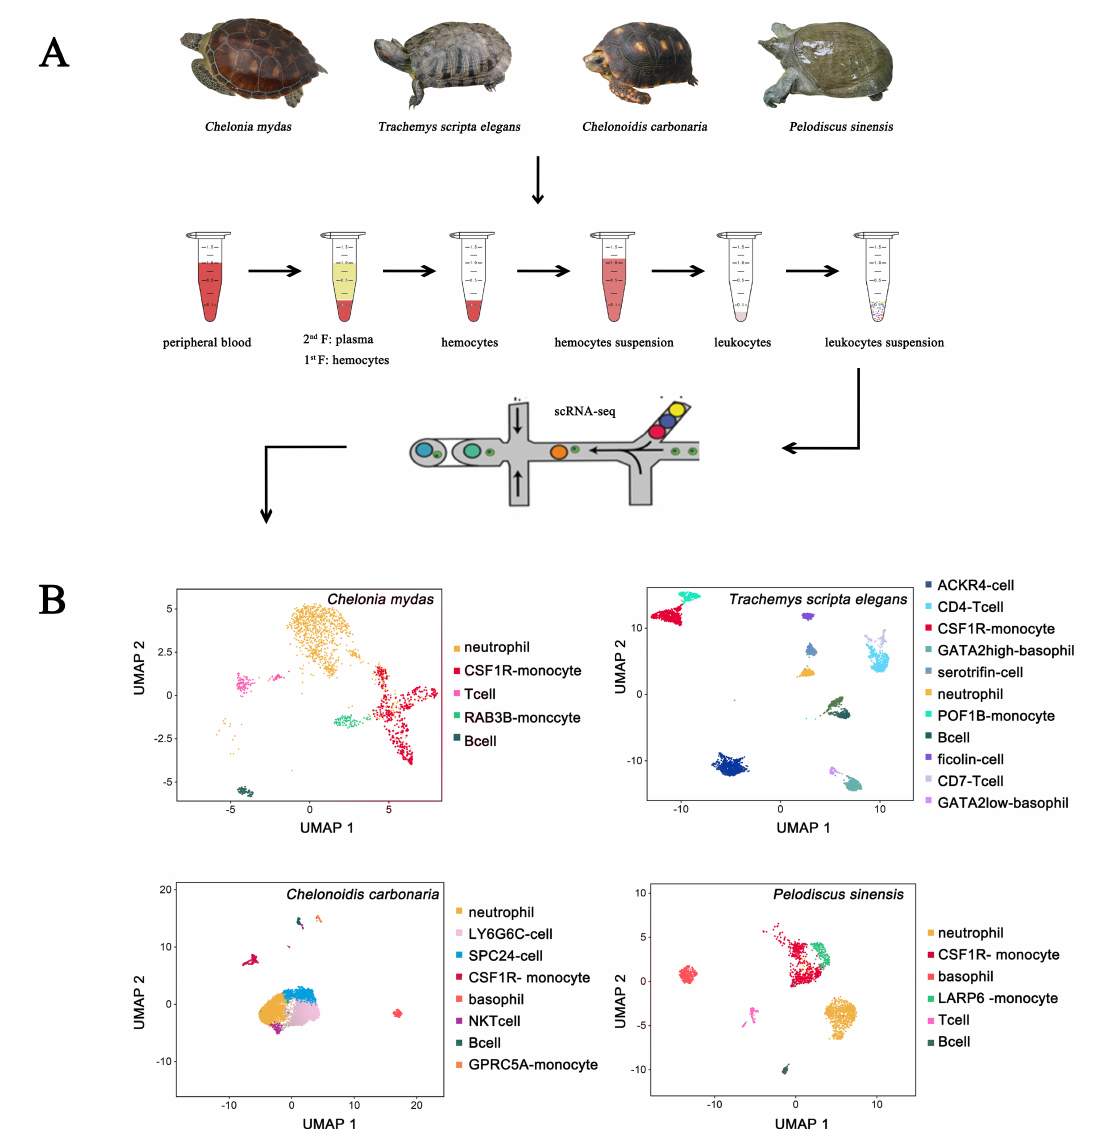
Figure 4. Transcriptome reference of peripheral immune cells. ( A ) A schematic workflow of the experimental design. ( B ) UMAP showing the distribution of peripheral immune cell types among the four